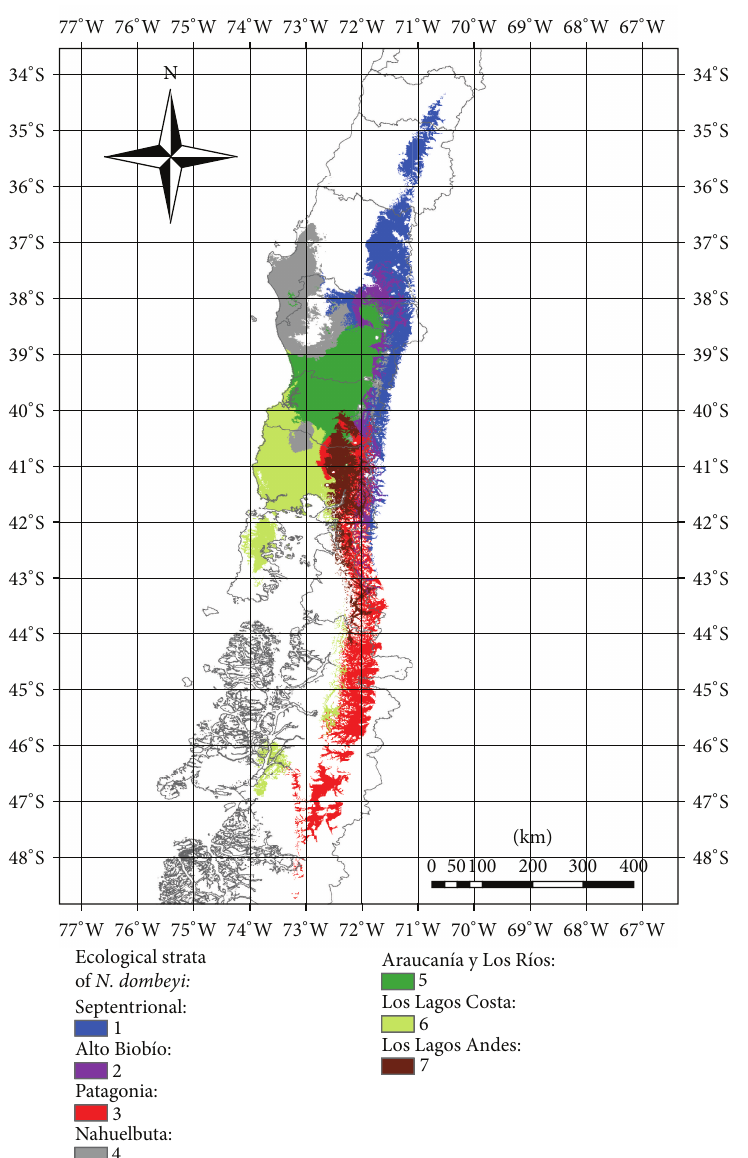
Figure 1: Using ecological niche models to identify different strata for Nothofagus dombeyi in Chile.